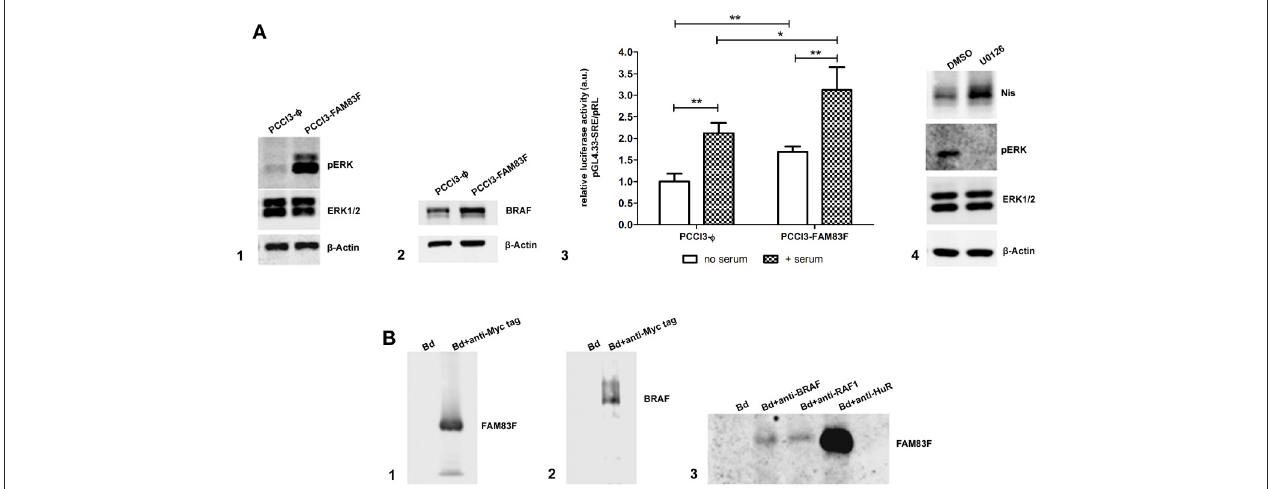
FIGURE 6 | FAM83F overexpression effect on MAPK signaling. (A) Analysis of MAPK signaling components protein expression and activation in rat thyroid follicular cells PCCL3 cells overexpressing FAM83F; (A1) Western-blotting of pERK and ERK1/2 levels; (A2) Western-blotting of BRAF protein levels; (A3) luciferase reporter assay with the pGL4.33[luc2P/SRE/Hygro] plasmid that contains serum-responsive elements activated by MAPK/ERK signaling in PCCL3-FAM83F after 2h of serum addition to culture medium. Results are shown as mean normalized values (luminescence of pGL/ luminescence of pRL plasmid). * P < 0.05 and ** P < 0.01. (A4) Western-blotting of Nis in PCCL3-FAM83F cells treated with MAPK signaling inhibitor U0126 at 5 uM for 48h. (B) Immunoprecipitation (IP) in PCCL3-FAM83F cells using a anti-Myc Tag antibody to immunoprecipitate FAM83F protein (Myc-tagged); (B1) Detection of FAM83F protein levels in Myc-Tag IP lysate by WB; (B2) Detection of BRAF protein levels in Myc-Tag IP lysate by WB; (B3) Immunoprecipation of BRAF, RAF1, and HuR followed by detection of FAM83F in PCCL3-FAM83F cells by WB. Bd group stands for beads only IP (no antibody).